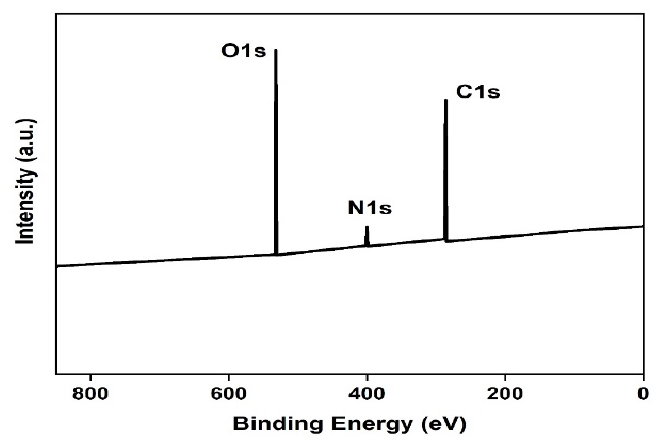
Figure 5. XPS spectrum of the CDs.